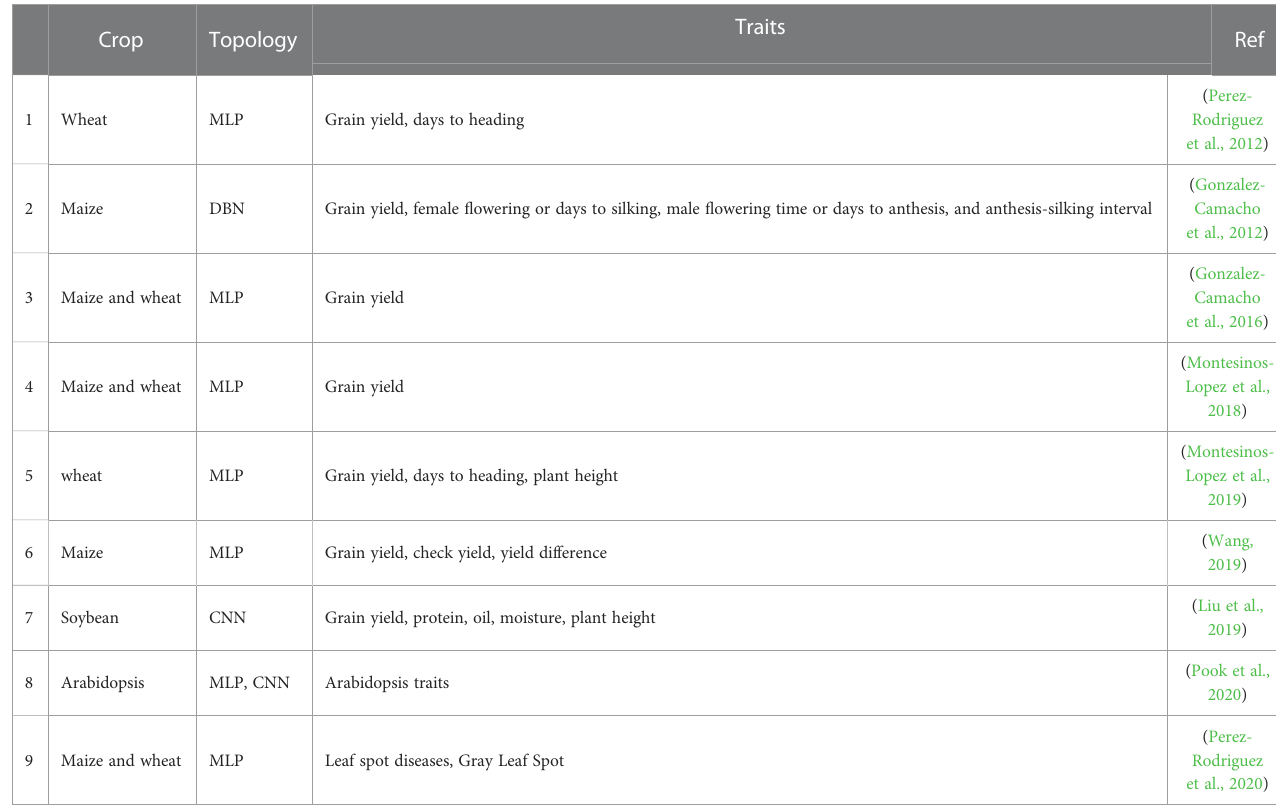
TABLE 3 Deep learning application to GS in